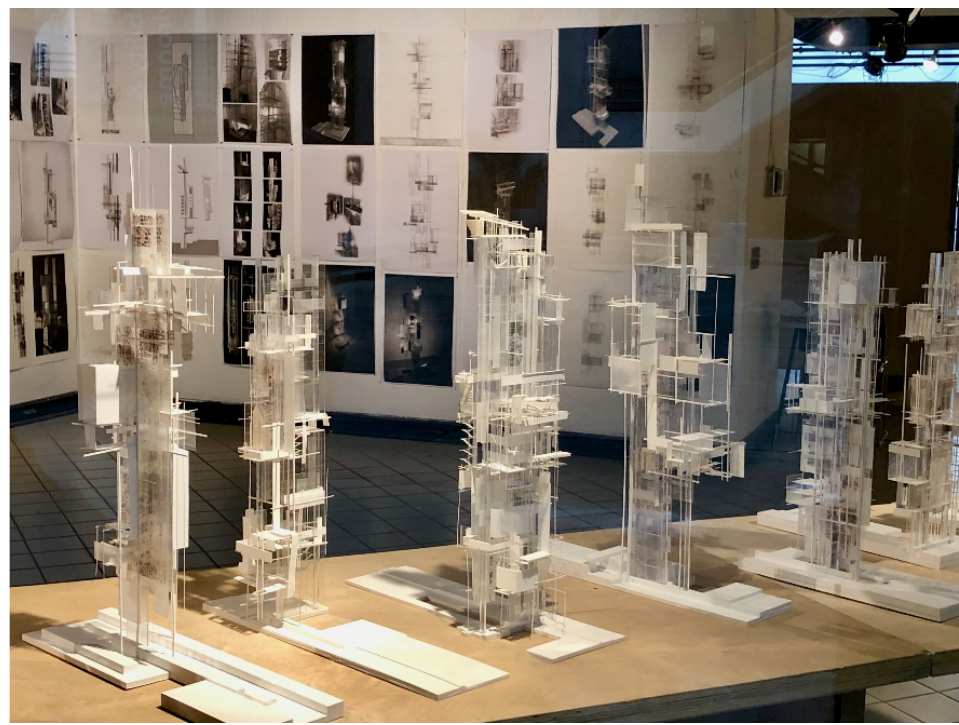
Figure 1. Teaching Gallery, UF School of Architecture, 2019.